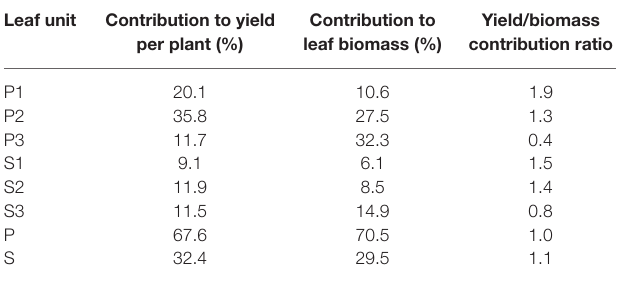
TABLE 1 | Relative contribution of P and S leaf production units to total biomass and H1 yield per plant following heterologous expression.